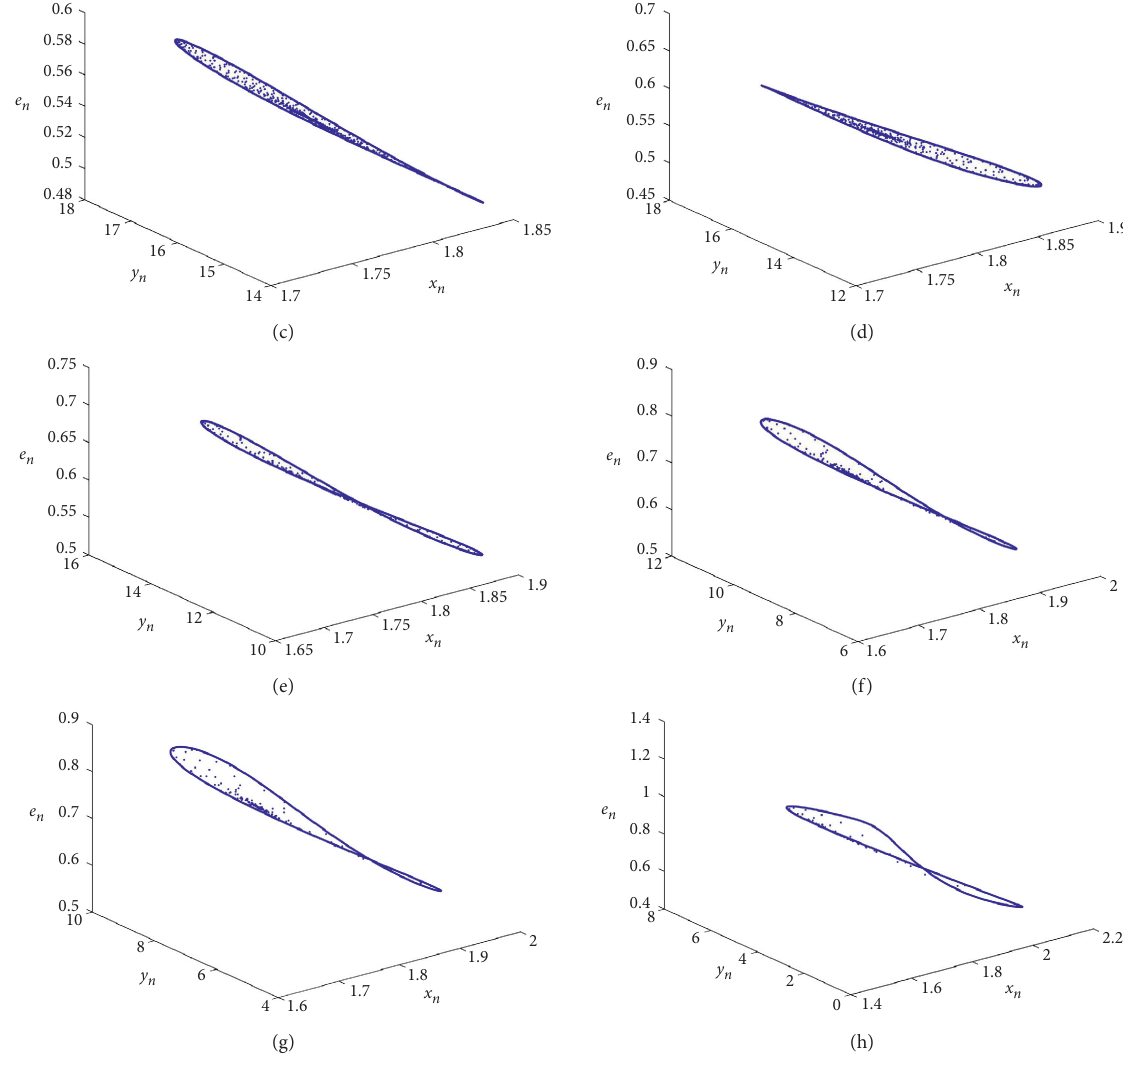
Figure 6: Phase portraits of system (4) for a � 41 . 5, b � 85, c � 2 . 7, d � 3 . 4, k � 1 . 4, r � 3 . 5, p � 2 . 3, and h � 0 . 75 and with different values of μ ∈ [ 0 . 678396 , 1 . 1 ] . (a) Phase portrait for μ � 0 :678396. (b) Phase portrait for μ � 0:7. (c) Phase portrait for μ � 0:75. (d) Phase portrait for μ � 0 :8. (e) Phase portrait for μ � 0:85. (f) Phase portrait for μ � 0:95. (g) Phase portrait for μ � 1. (h) Phase portrait for μ � 1